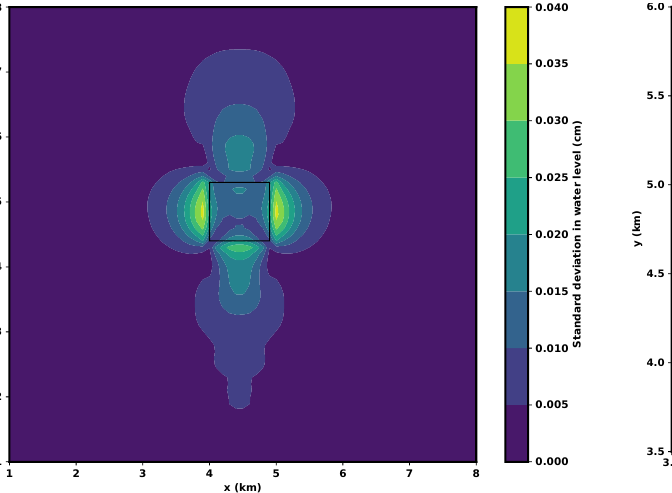
Figure 6. Standard deviation in water level in the presence of veg- etation (plan view). The area of the vegetation patch is highlighted in the middle of the domain.